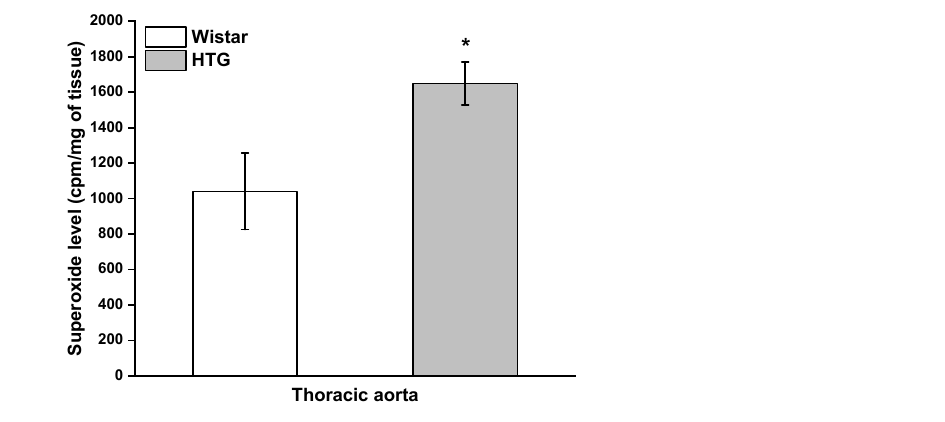
Figure 7. Superoxide level in the aortain Wistar rats (n = 7) and hypertriglyceridemic rats (HTG, n = 8). The results are presented as the mean ± S.E.M., and differences between groups were analyzed by one-way ANOVA with the Bonferroni post hoc test. * p < 0.05 vs. HTG.